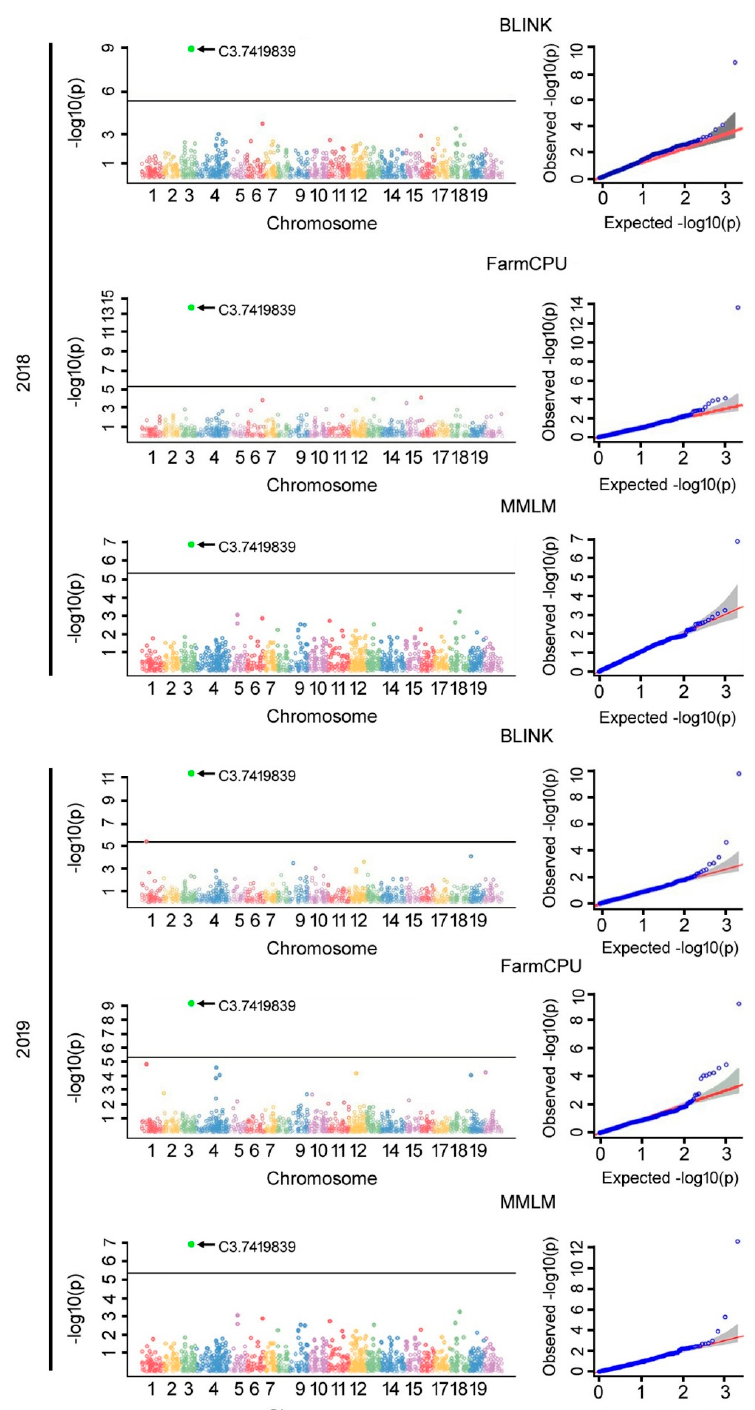
Figure 2. Multivariate GWAS models BLINK, FarmCPU, and MMLM predicted PM resistance in pumpkins. Over a two-year study (2018 and 2019), different multi-locus based GWAS models, i.e., BLINK, FarmCPU, and MMLM, were used for the prediction of potential SNPs associated with PM resistance in 407 pumpkin genotypes. The black arrow denotes most significant association. In the Manhattan plot, the horizontal solid line indicates the Bonferroni-corrected significance threshold value at –log10( p ) of 4.61. Different colors in the Manhattan plots represents different chromosomes in pumpkin. For different models, the Manhattan and quantile–quantile plots are presented on the left and right panels,